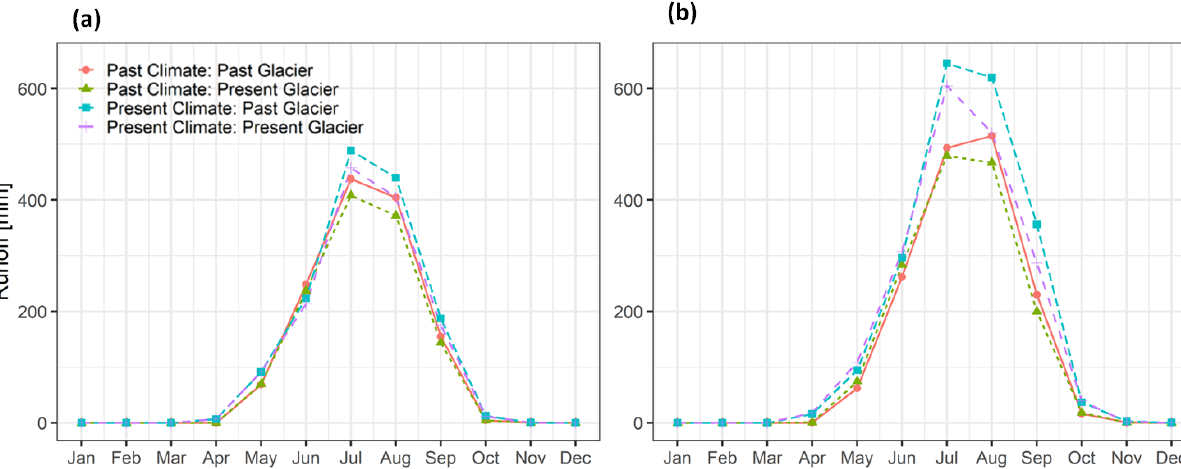
Figure 8. Monthly averaged runoff simulated using the past and present glacier and climate scenarios. (a) AGRB. (b)